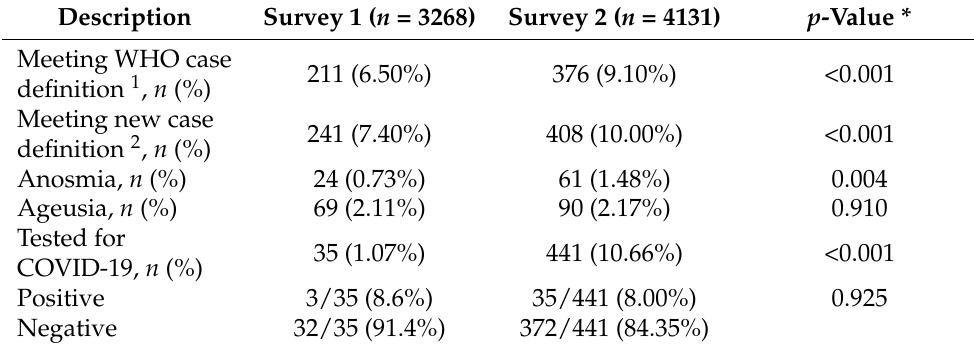
Table 5. Proportion of suspected and confirmed COVID-19 infected respondents according to the clinical